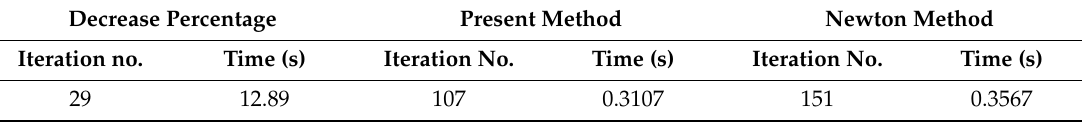
Figure 5. Space truss with 42–members, all dimensions are in mm. Table 2. Comparison of computational cost and iteration number